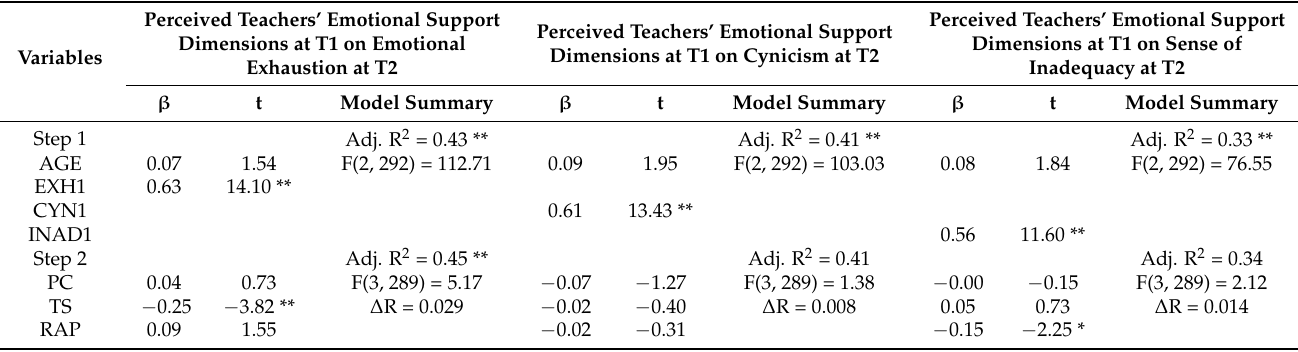
Table 2. Hierarchical multiple regression analyses of perceived teacher emotional support dimensions at T1 on burnout dimensions at